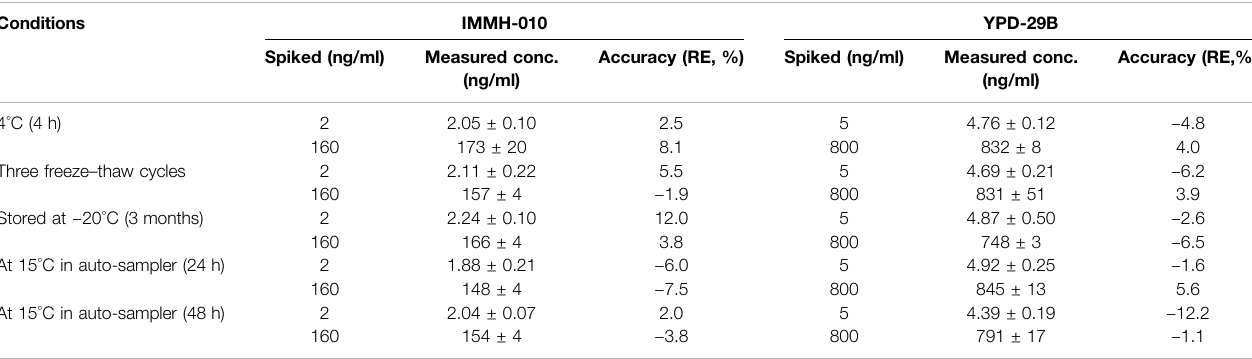
TABLE 5 | Stability of IMMH-010 and YPD-29B in rat plasma ( n (cid:1) 5). Conditions IMMH-010 YPD-29B Spiked (ng/ml) Measured conc. Accuracy (RE, %) Spiked (ng/ml) Measured conc. (ng/ml) (ng/ml)